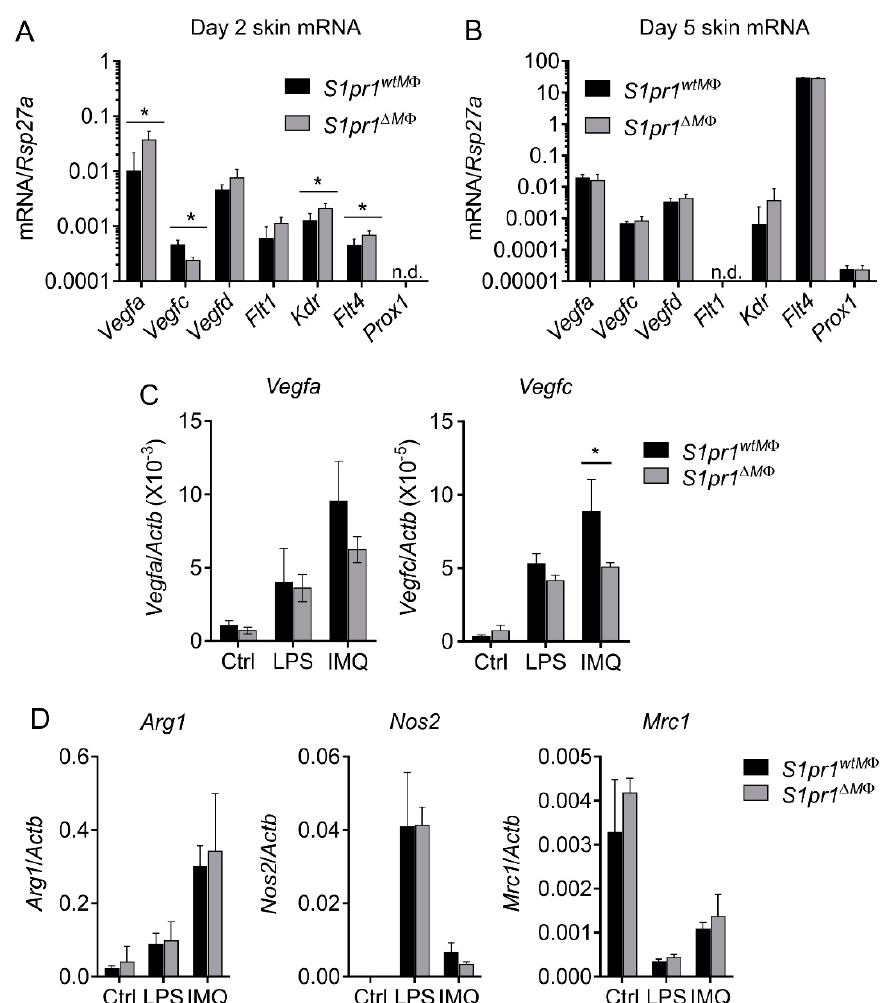
Figure 7. Myeloid S1PR1 is involved in the regulation of VEGFs and their receptors but not in macrophage polarization. ( A , B ) S1pr1 wtM Φ (black bar) and S1pr1 ∆ M Φ (grey bar) mice were treated daily with 62.5 mg IMQ on the back skin for up to 5 days. Gene expression analysis by qPCR for VEGF-A, VEGF-C, VEGF-D, VEGF-R1, VEGF-R2, VEGF-R3 and PROX-1 on whole back skin at day 2 ( A ) and day 5 ( B ). Data are means ± SD, n = 4–8 individual animals. Bone marrow-derived macrophages were stimulated with 100 ng / mL lipopolysaccharide (LPS) and 10 µ g / mL IMQ for 16 h and mRNA expression of ( C ) VEGF-A and VEGF-C, and ( D ) macrophage polarization markers ARG1, iNOS ( Nos2 ) and CD206 ( Mrc1 ) was analyzed by qPCR. Data are means ± SD, n = 4 individual animals. * p < 0.05; p values were calculated using two-tailed multiple t -test with Holm–Š í d á k correction